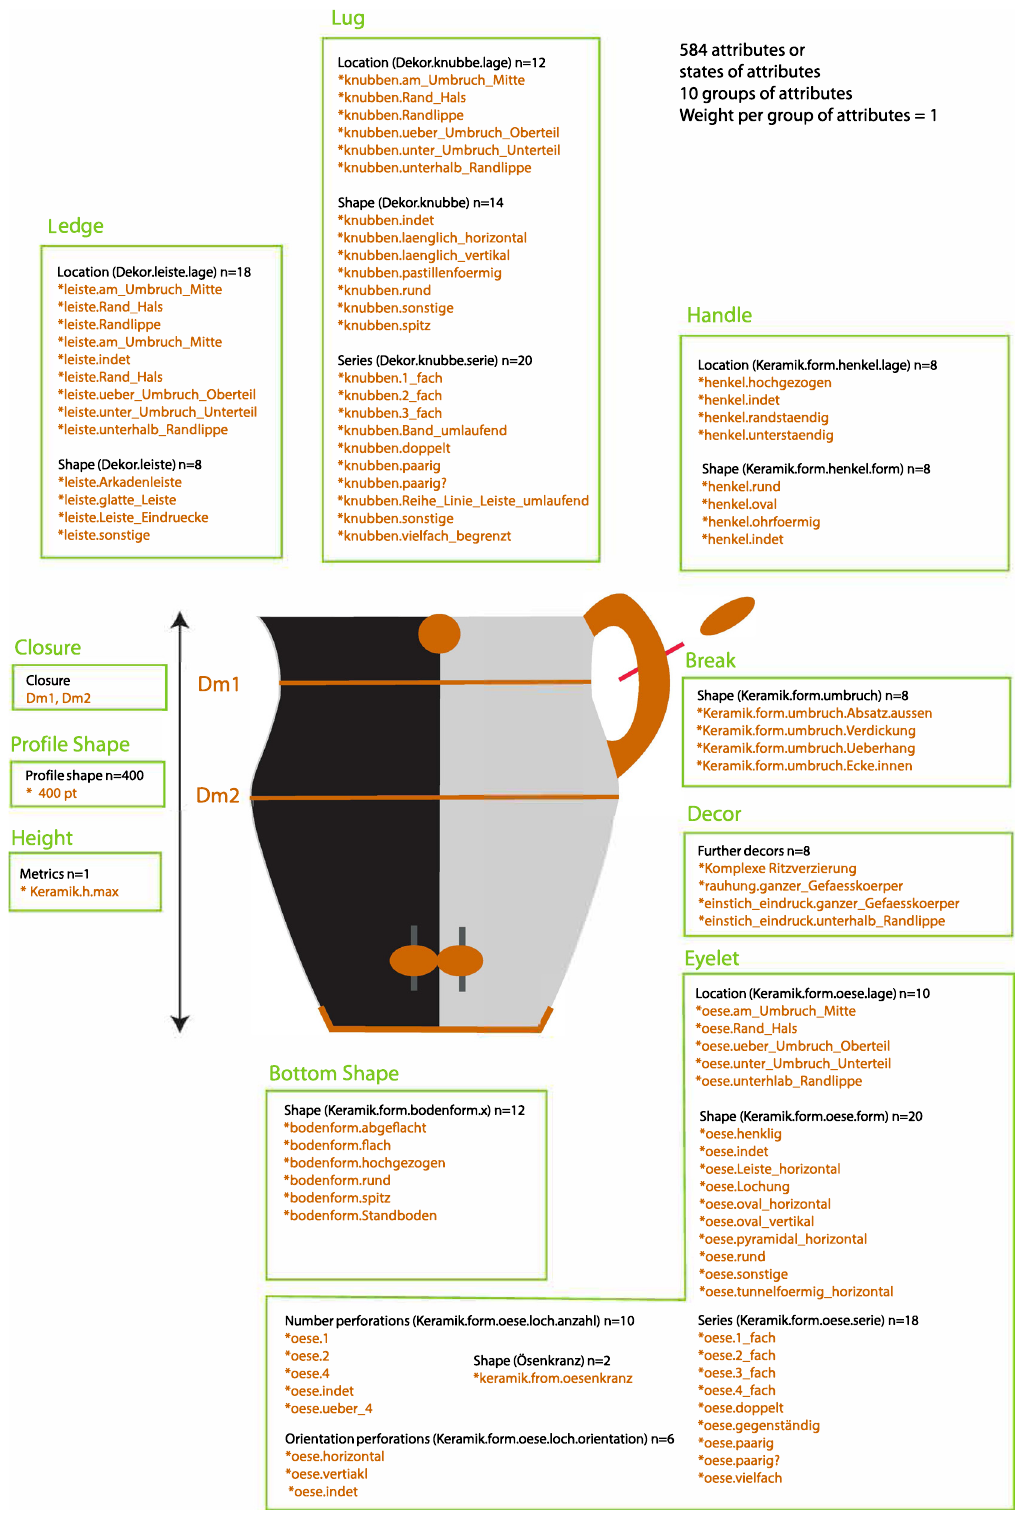
Figure 5: Attributes or states of attributes and their weighting ( fi gure: C. Heitz, for an English translation of all variables, see doi: 10.5281/zenodo.7258694 )